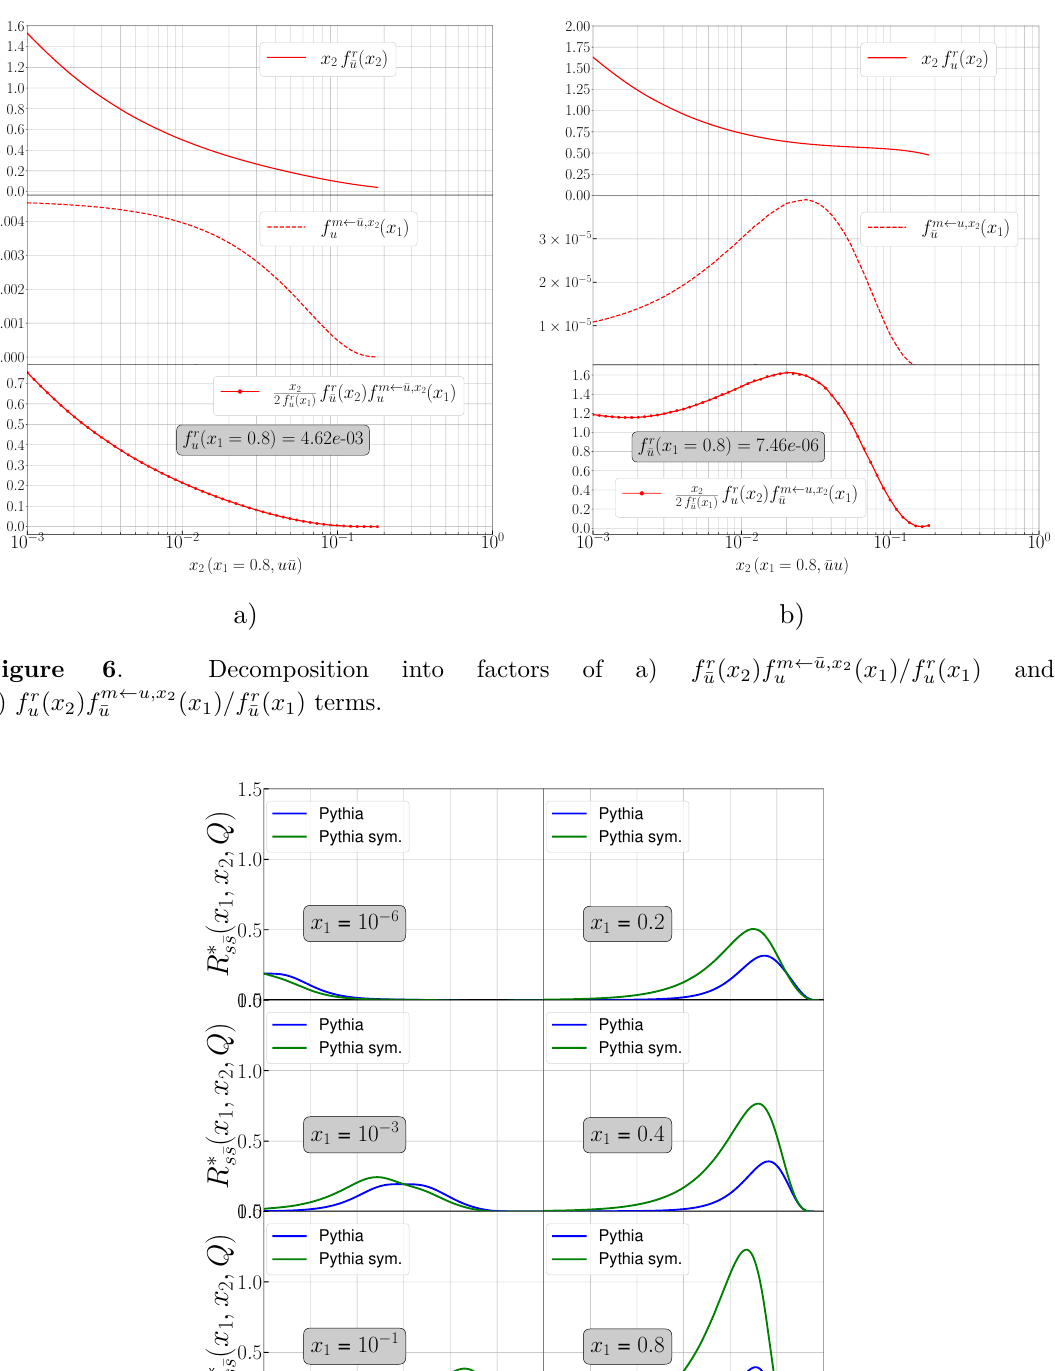
Figure 7 . Same as in figure 4 but for the R ∗